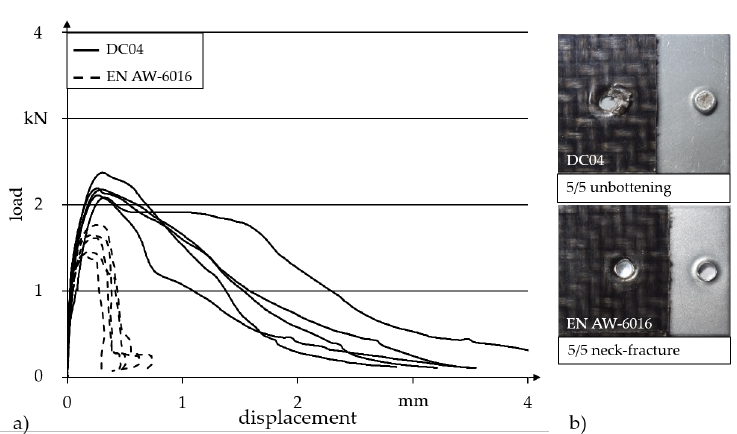
Figure 14. Hotclinching: Results of single-lap shear tests under quasi-static load for DC04 and EN AW-6016 as metallic joining partner: ( a ) load-displacement curves, ( b ) characteristic failure